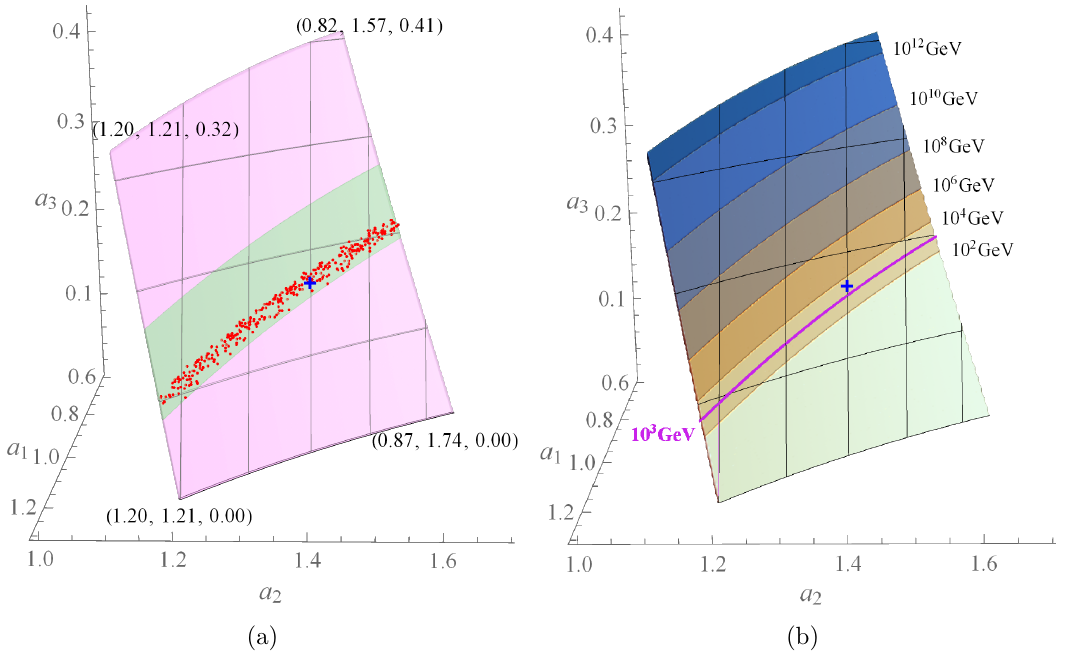
Figure 5 : (a) In magenta we show the “viable” region of Kähler moduli space that satisfies all constraints in section 2 for the line bundle L = O (2 , 1 , 3) . The RGE simulation produces X “black” points when ( a 1 , a 2 , a 3 ) are sampled within the green subregion. With red we show points in this green subspace where we find at least one acceptable “black” point-that is, a “red” point. The region of possible acceptable “black” points forms a strip. The blue cross indicates the point ( a 1 , a 2 , a 3 ) = (0 . 910 , 1 . 401 , 0 . 163) we used for the previous examples where we found the “black” and “red” points shown in figure 3. (b) Plot of the variation of the soft SUSY breaking parameter m across the “viable” region of Kähler moduli susy space in the simultaneous Wilson lines scenario with h α i − 1 = 26 . 46 . This was also shown u in figure 2(b), but we reproduce it here for ease of comparison. The blue cross indicates the point ( a 1 , a 2 , a 3 ) = (0 . 910 , 1 . 401 , 0 . 163) . The purple line is the m = 1 TeV susy